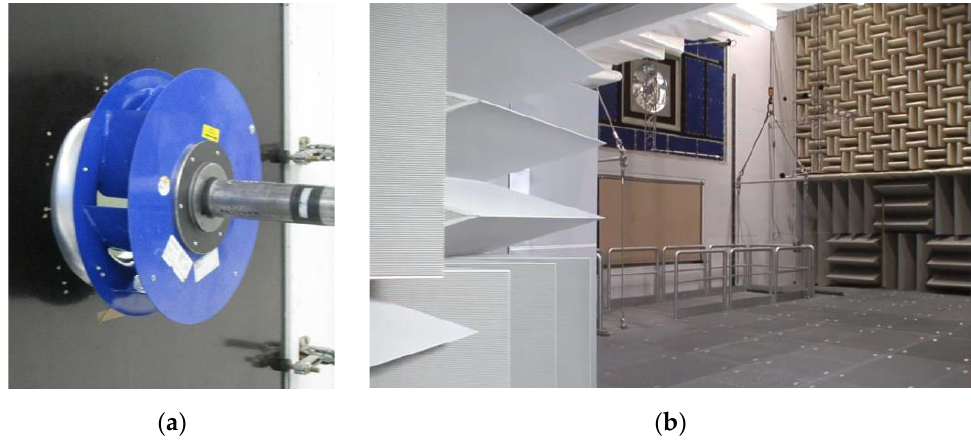
Figure 1. Experimental setup: ( a ) downstream view of the investigated fan; ( b ) anechoic test facilities at ZIEHL-ABEGG.